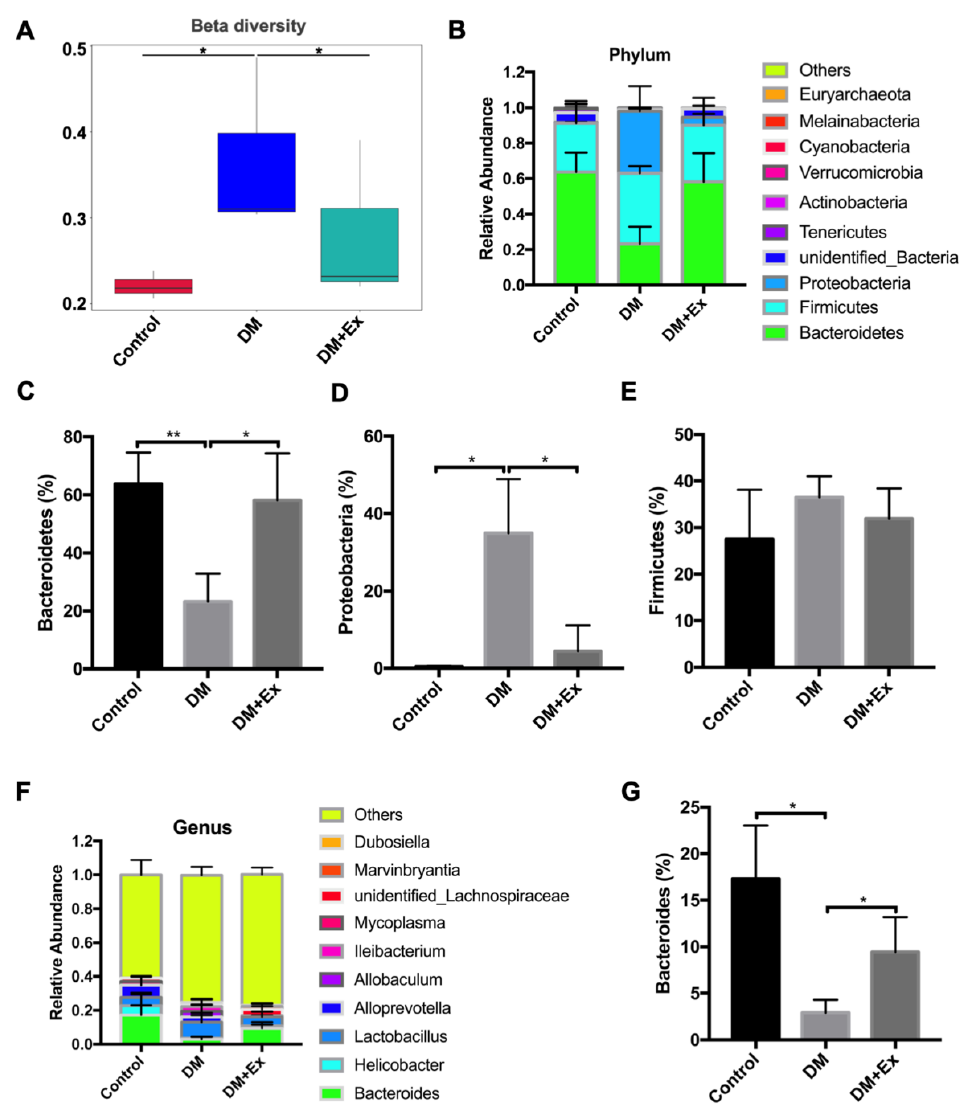
Figure 1. Exercise intervention a ff ects intestinal flora distribution in mice with diabetes mellitus (DM). ( A ) Mice were randomly divided into three groups (control, DM and DM + Ex) and modeled. Beta diversity analysis was determined by 16srRNA sequencing; ( B ) analysis of all intestinal flora in di ff erent groups at the phylum level; ( C – E ) proportion of Bacteroidetes, Firmicutes and Proteobacteria in each group; ( F ) Analysis of intestinal flora in di ff erent groups at the genus level; ( G ) proportion of Bacteroides in each group. Control—normal mice; DM—diabetes mellitus; DM + Ex—diabetic mice treated with exercise. * p < 0.05. ** p < 0.01.